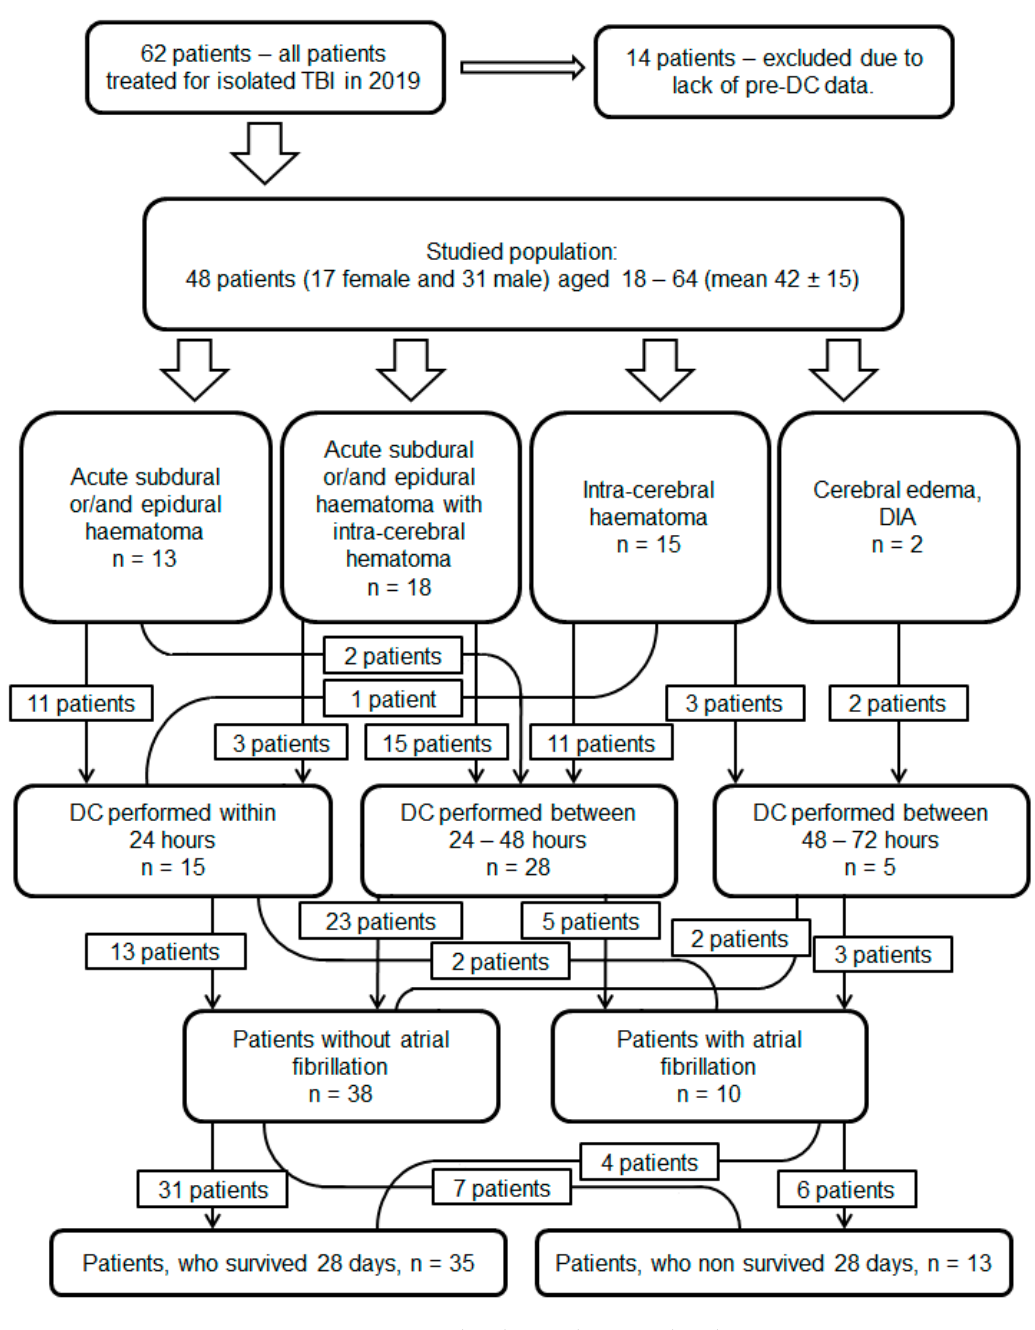
Figure 1. Demographic data and patient distribution.